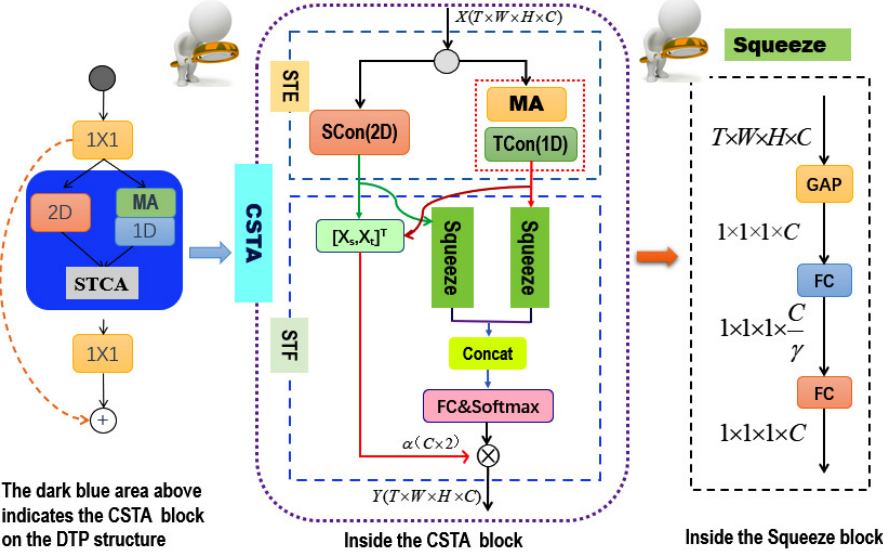
Figure 3. The illustration of the architecture after replacing standard convolution in Resnet block by the new proposed